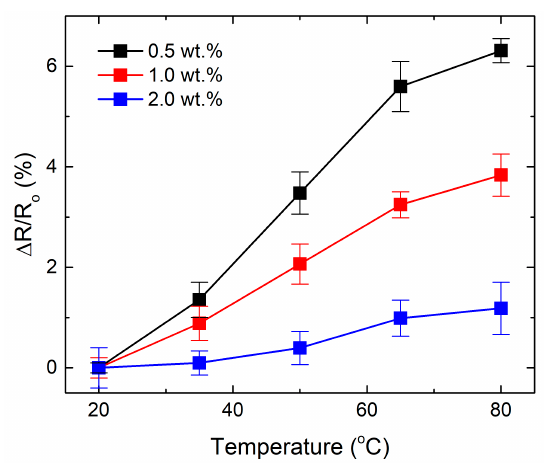
Figure 5. The e ff ect of temperature on the change in resistance of CNT / epoxy composites at Figure 5. The effect of temperature on the change in resistance of CNT/epoxy composites at rest.